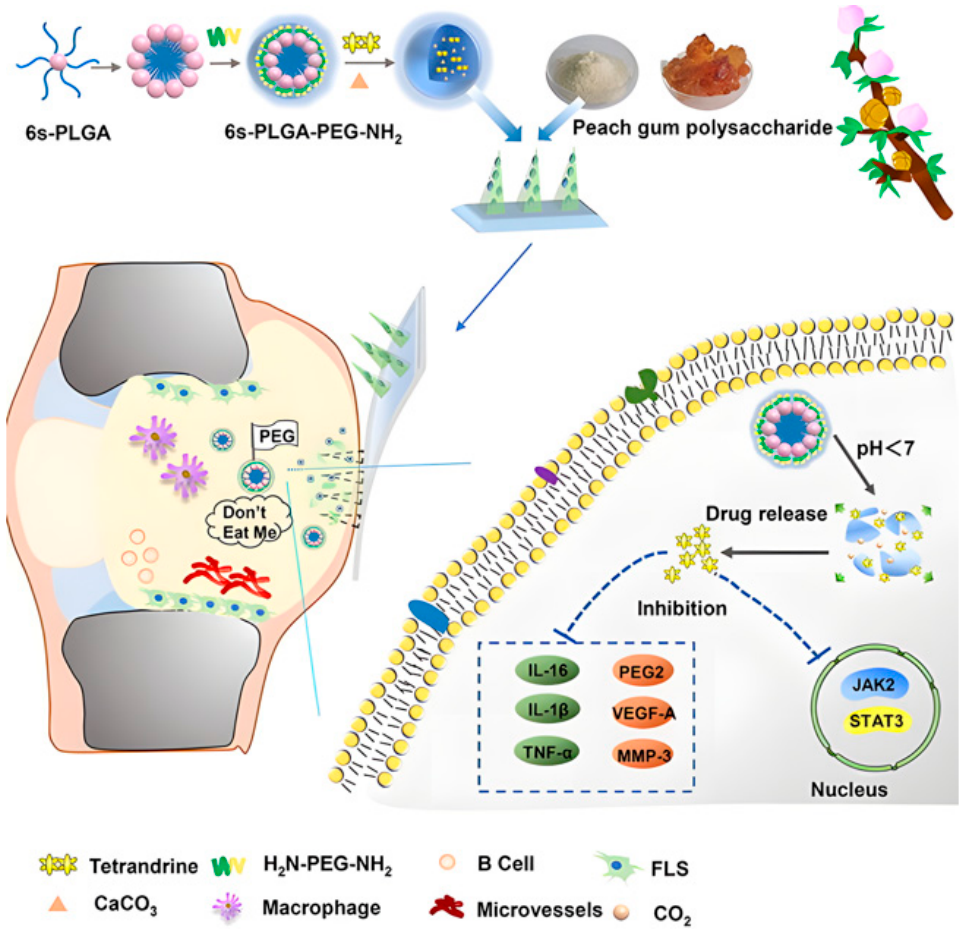
Figure 15. Schematic representation of the preparation of acid-responsive released [6s-NPs (CaCO 3 )] MN and the in vivo regulation of the VEGF, JAK2, and STAT3 pathways for the treatment of Rheumatoid Arthritis (RA) [198]. Reproduced with permission from Hu, Hongmei, Chemical Engineering Journal; published by Elsevier, 2022.